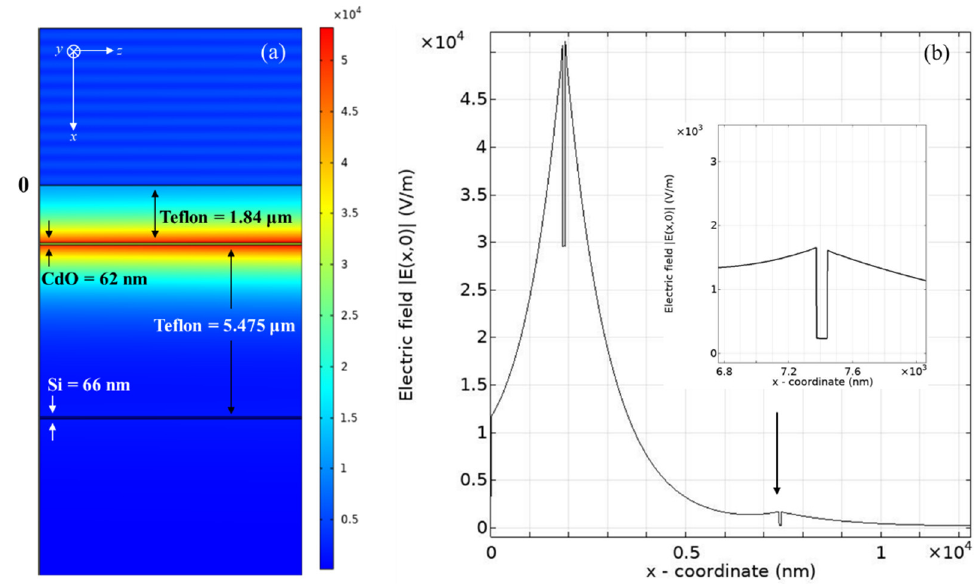
Figure 8. ( a ) Surface electric field and ( b ) the corresponding electric field distribution at the incident angle of 32.5717° in the proposed six ‐ layer hybrid structure.